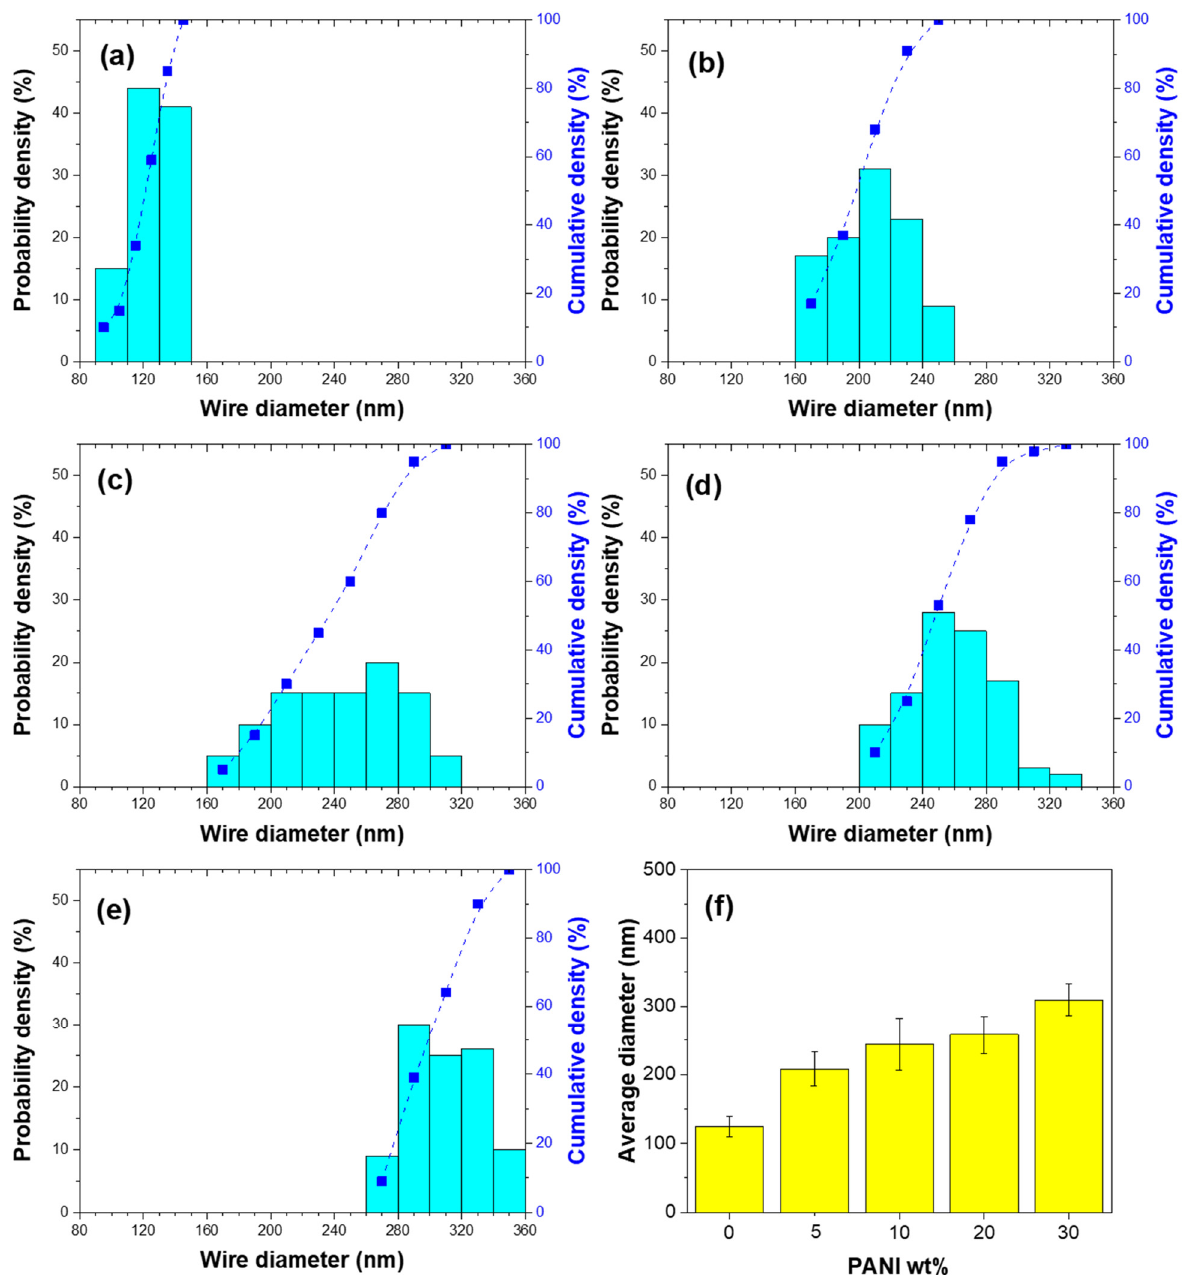
Figure 3. Nanowire diameter distribution, the probability density (bar chart) and the cumulative density (line with symbols), of ( a ) Fe nanowires, ( b ) Fe@PANI-95/5, ( c ) Fe@PANI-90/10, ( d ) Fe@PANI-80/20, ( e ) Fe@PANI-70/30, and ( f ) average diameter vs. PANI content. The connecting spline dotted curves are only to guide the eyes for the observation of the